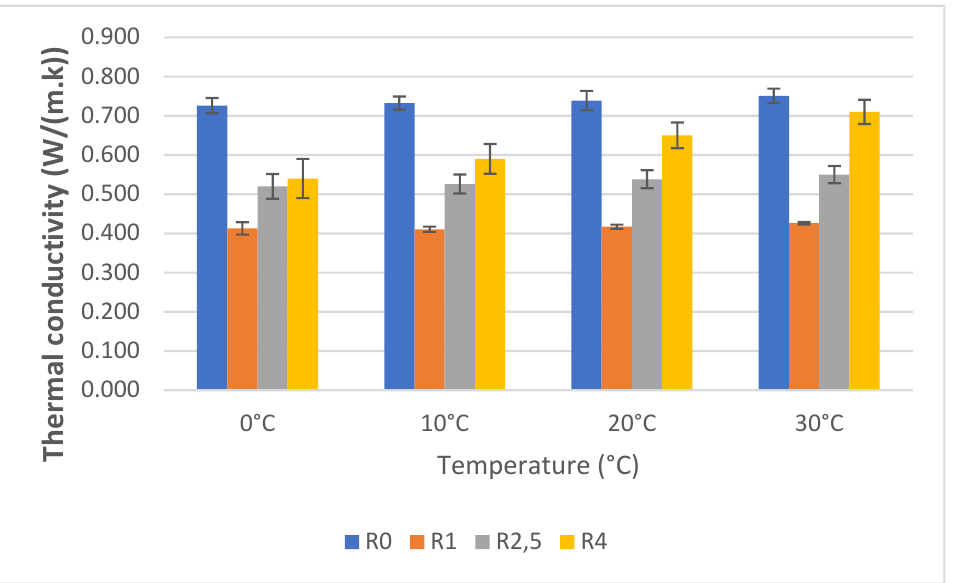
Figure 9. Thermal conductivity of cob compositions as a function of the temperature and the Sargassum muticum content.